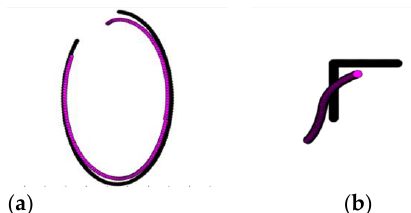
Figure 6: Results for controller on simulations: ( a ) In circular path; ( b ) In square path.